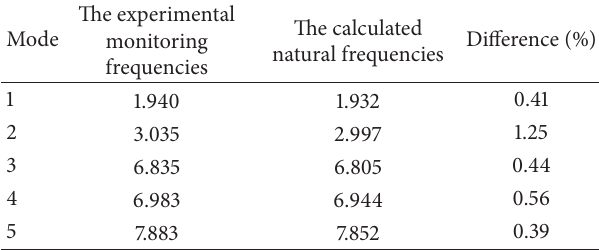
Table 1: Calculated natural frequencies from the FE model. The experimental Mode monitoring